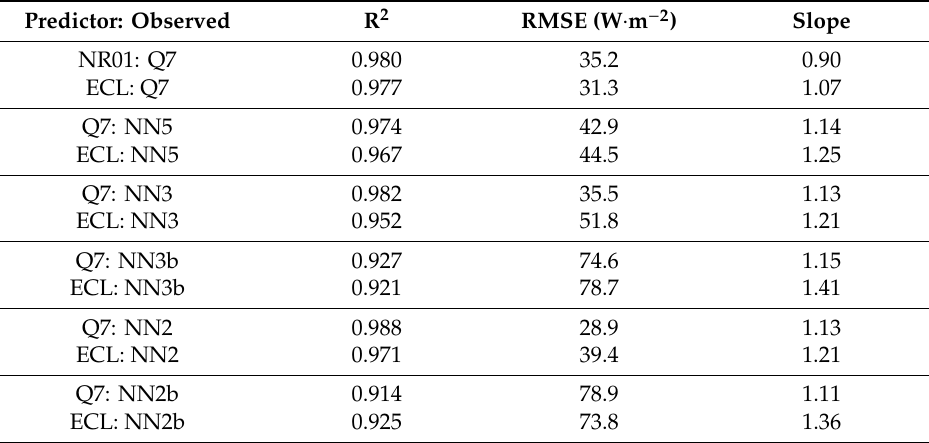
Figure 6. Modelled shortwave irradiance on 21 August 2017, during the Great American Solar Eclipse. Table 5. NN models outputs compared to measured net radiation. Included are comparisons of net radiation measured by Q7 and NR01 sensors during the training period and during the subsequent experiment conducted around the eclipse (ECL). Data from training periods were